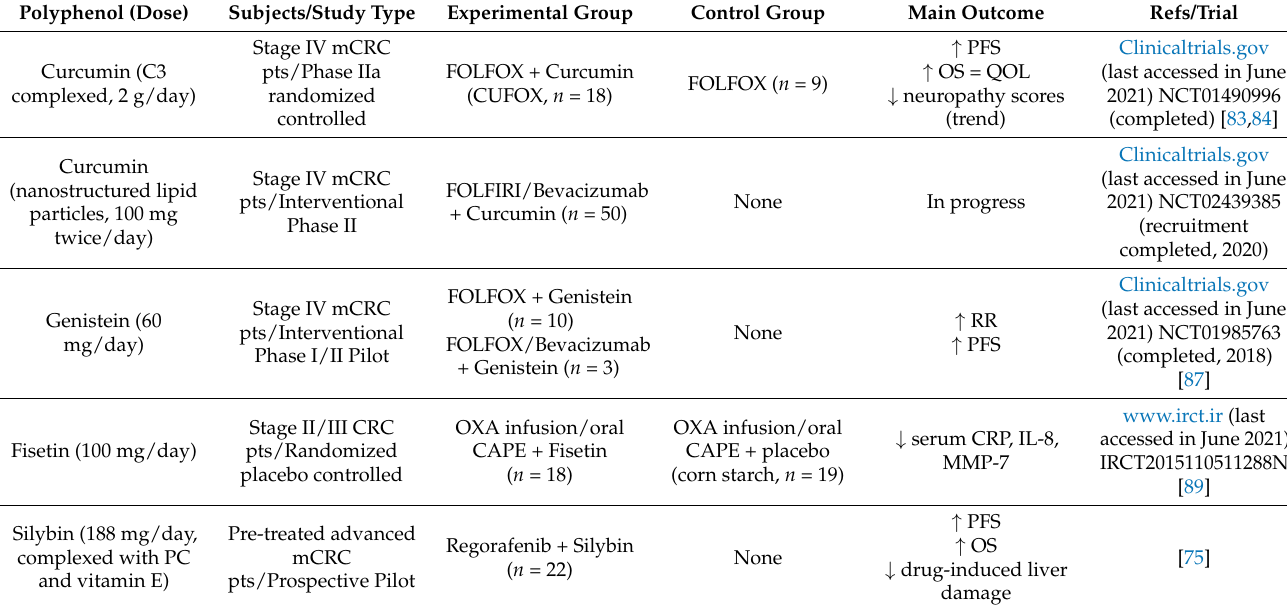
Table 2. Clinical studies evaluating the effects of polyphenols and standard therapy combination in CRC patients. Polyphenol